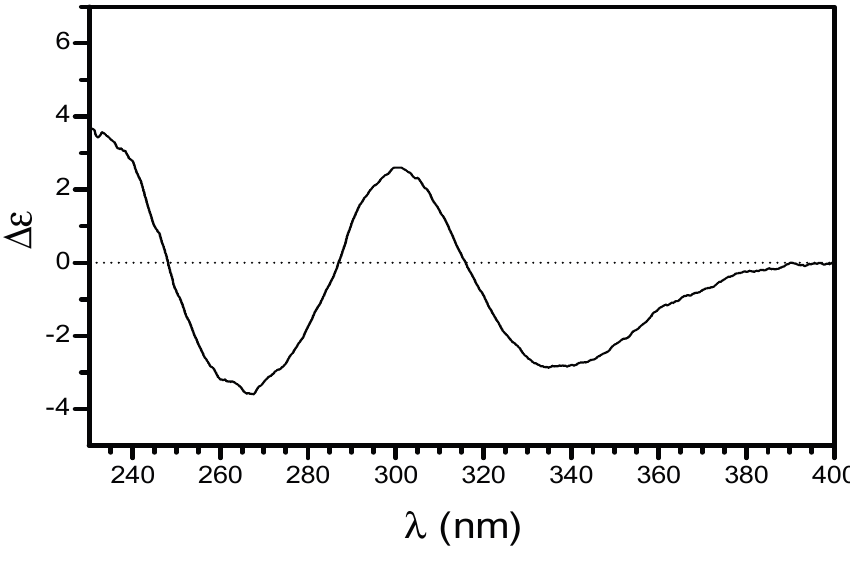
Figure 3. Circular dichroism spectrum of 1 in